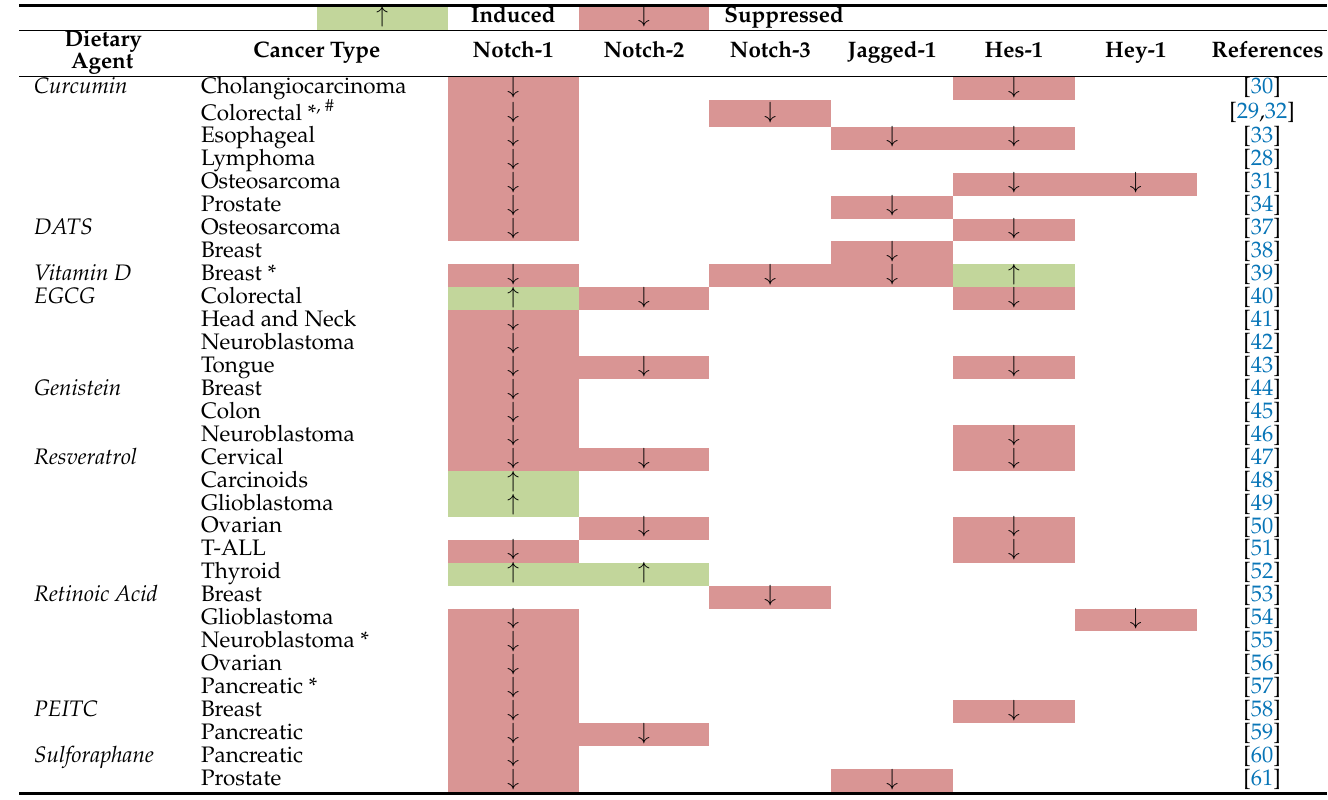
Table 1. Effect of dietary agents on Notch pathway components in vitro by cancer type.